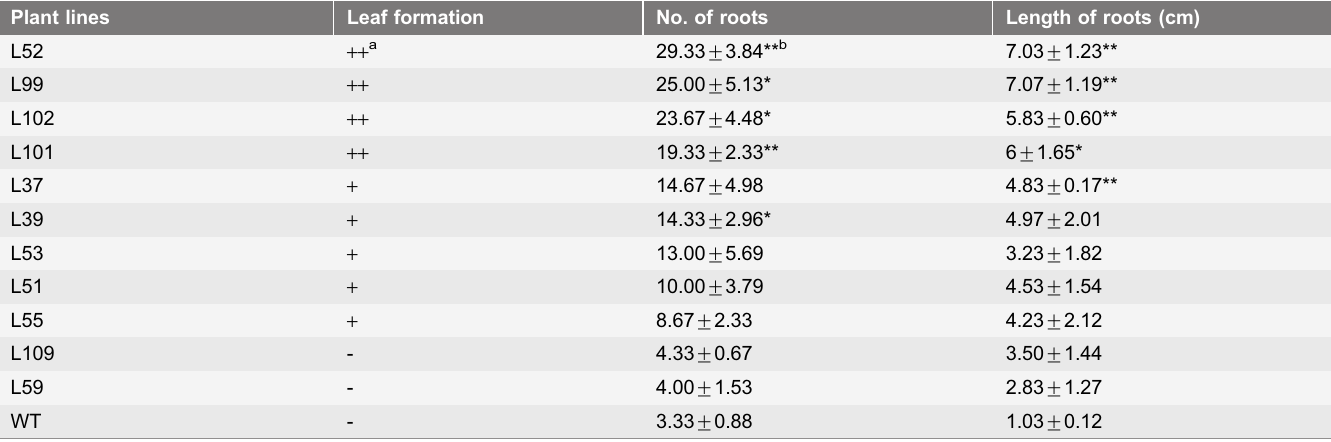
a ‘ ++ ’ indicates that cuttings formed obvious new leaves; ‘ + ’ indicates that cuttings survived, but failed to form new leaves; ‘-’ indicates that cuttings died. b Data are presented as means ¡ SE (n 5 3). * and ** indicate a significant difference from that of the wild-type (WT) at P , 0.05 and , 0.01, respectively, by Student’s t